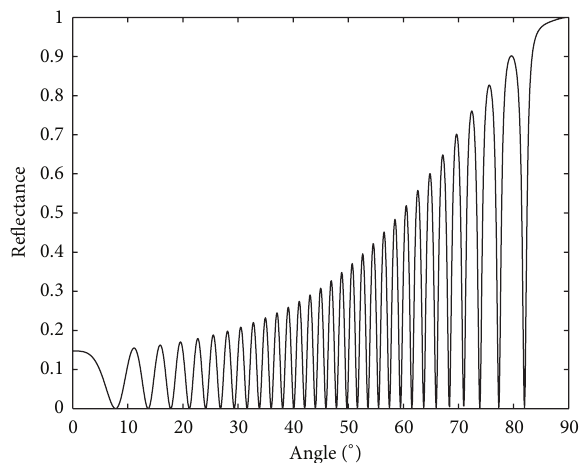
Figure 4: Reflectance of a homogeneous dielectric slab embedded in air with thickness 25 𝜇 m and refractive index